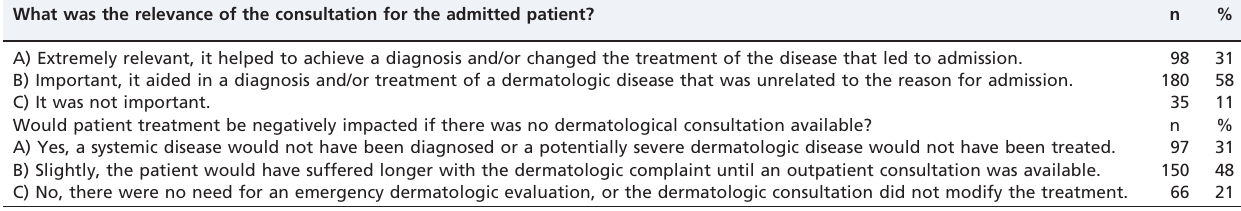
Table 3 - Questions used to evaluate the impact of dermatological